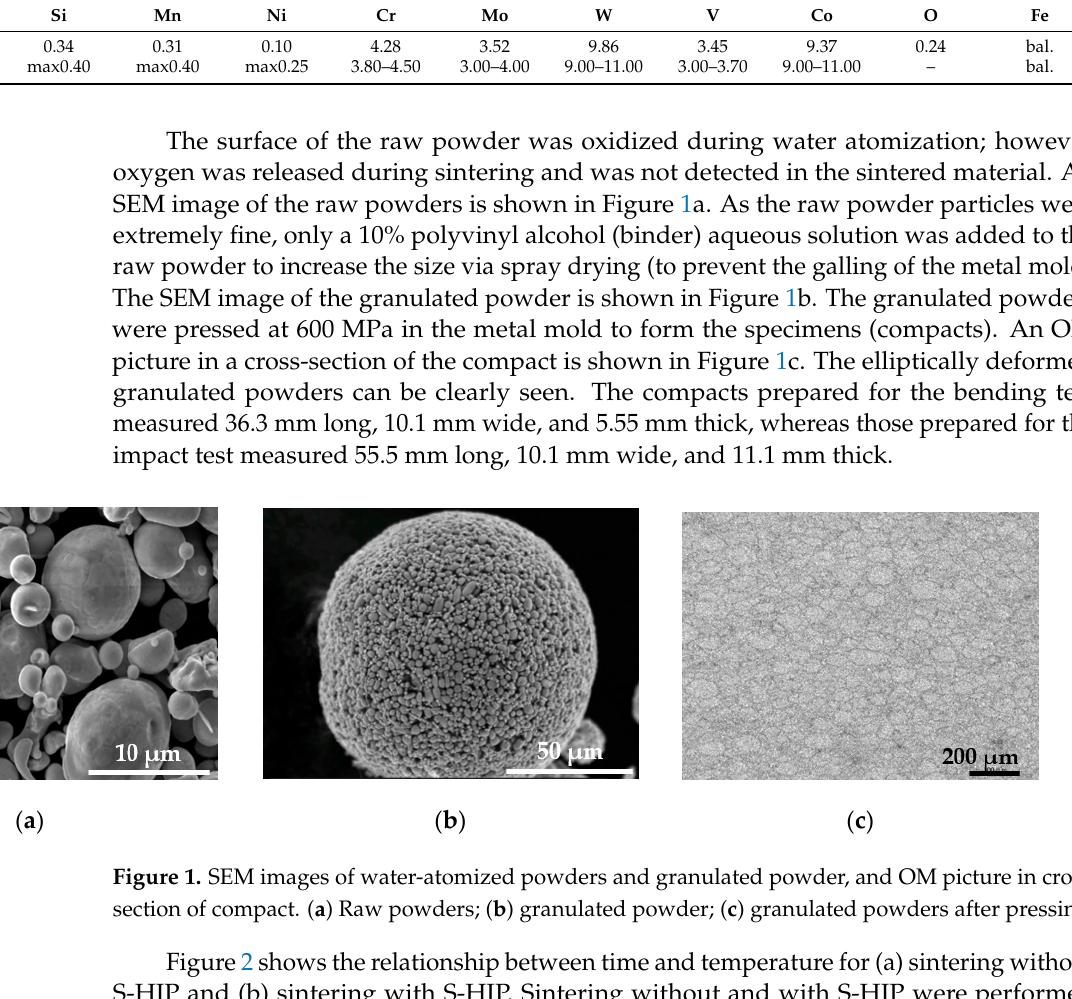
Table 1. Chemical compositions of SKH57 raw powders (mass%).